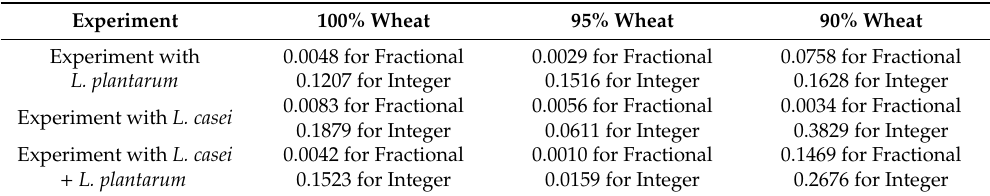
Table 1. Mean square errors for each experiment.